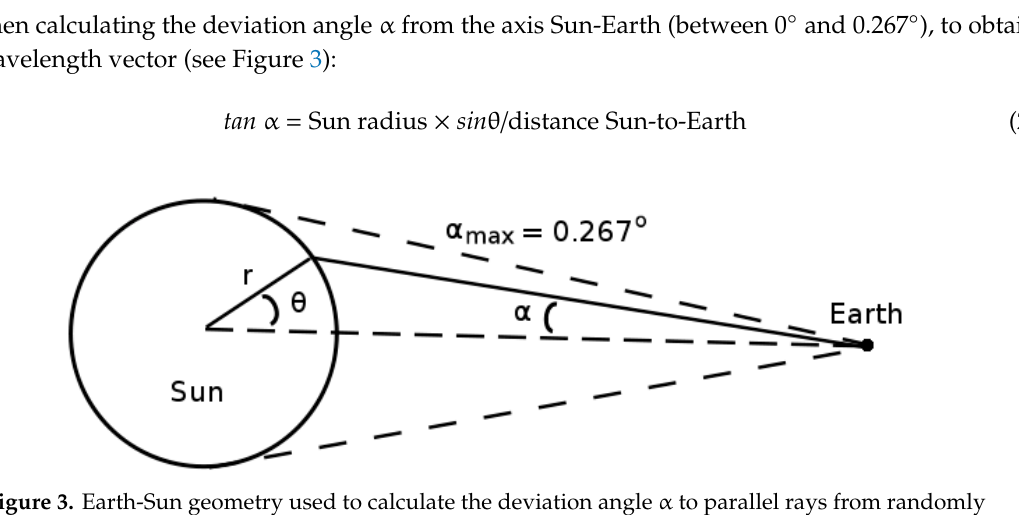
Figure 3. Earth-Sun geometry used to calculate the deviation angle α to parallel rays from randomly generated angle θ , in spherical coordinates.